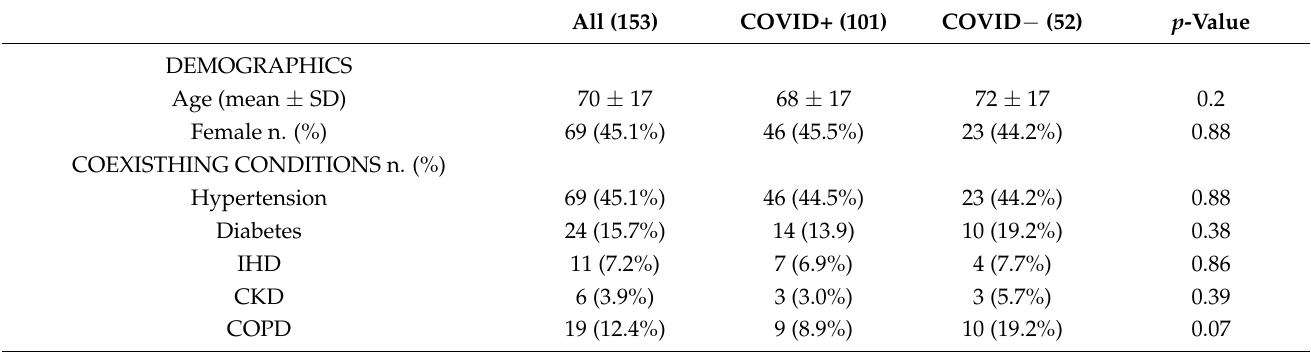
Table 1. Patient characteristics. Abbreviations: IHD, Ischemic Heart Disease; CKD, Chronic Kidney Failure; COPD, Chronic Obstructive Pulmonary Disease; RR, respiratory rate; MBP, mean blood pressure; HR, heart rate; BT, body temperature; WBCs, white blood cell; CPR, C-Protein